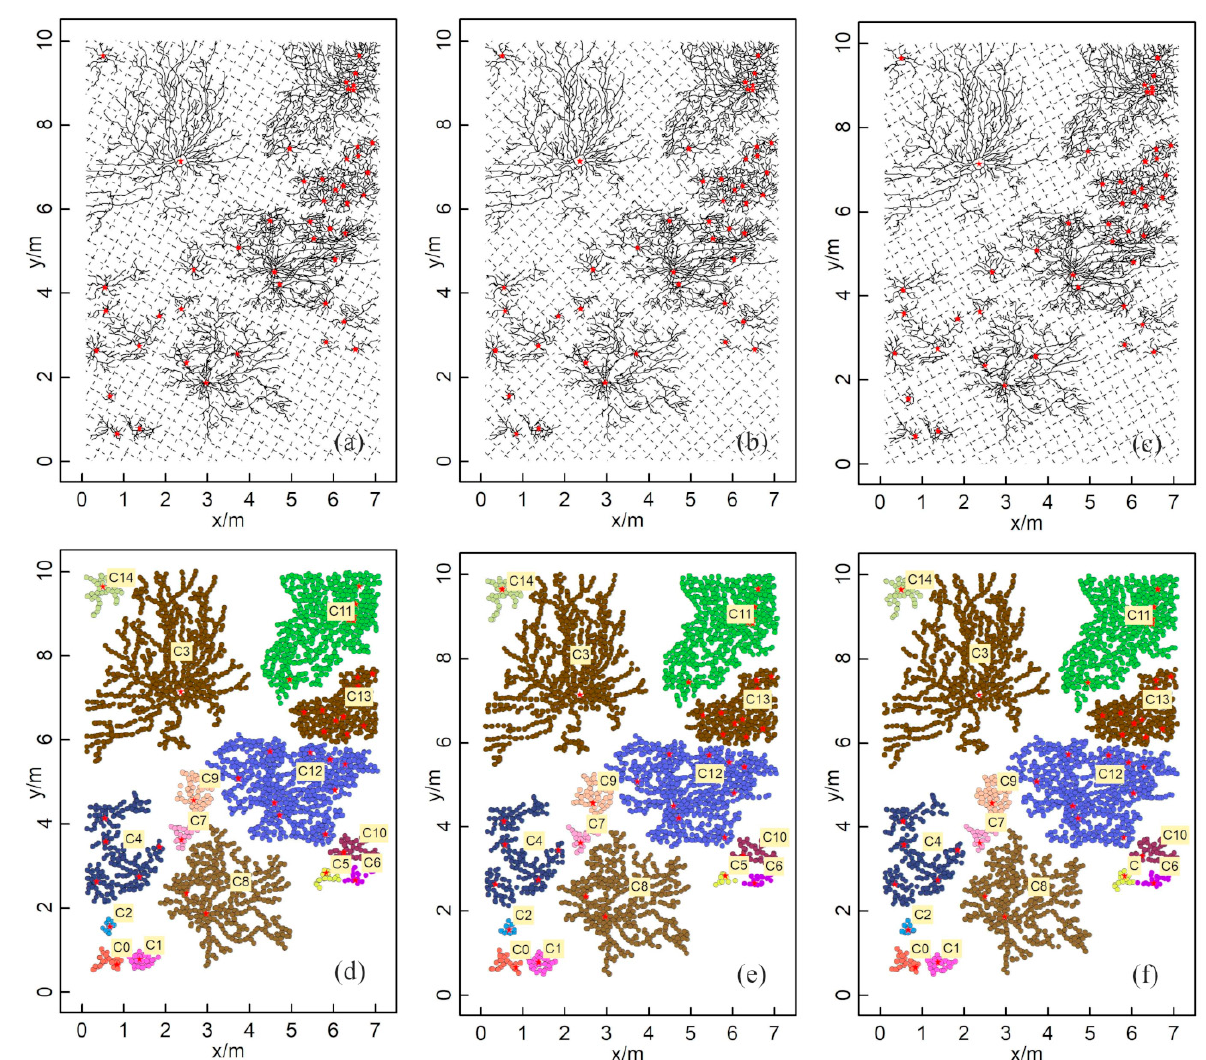
Figure 9. Results after changing the survey line direction with the simulated data. The survey line interval was 10 cm. The results of the counterclockwise rotation of the survey line by 30°, 45°, and 60° are shown in ( a – c ), respectively. The distribution maps of the corresponding ZOIs are in ( d – f ) .